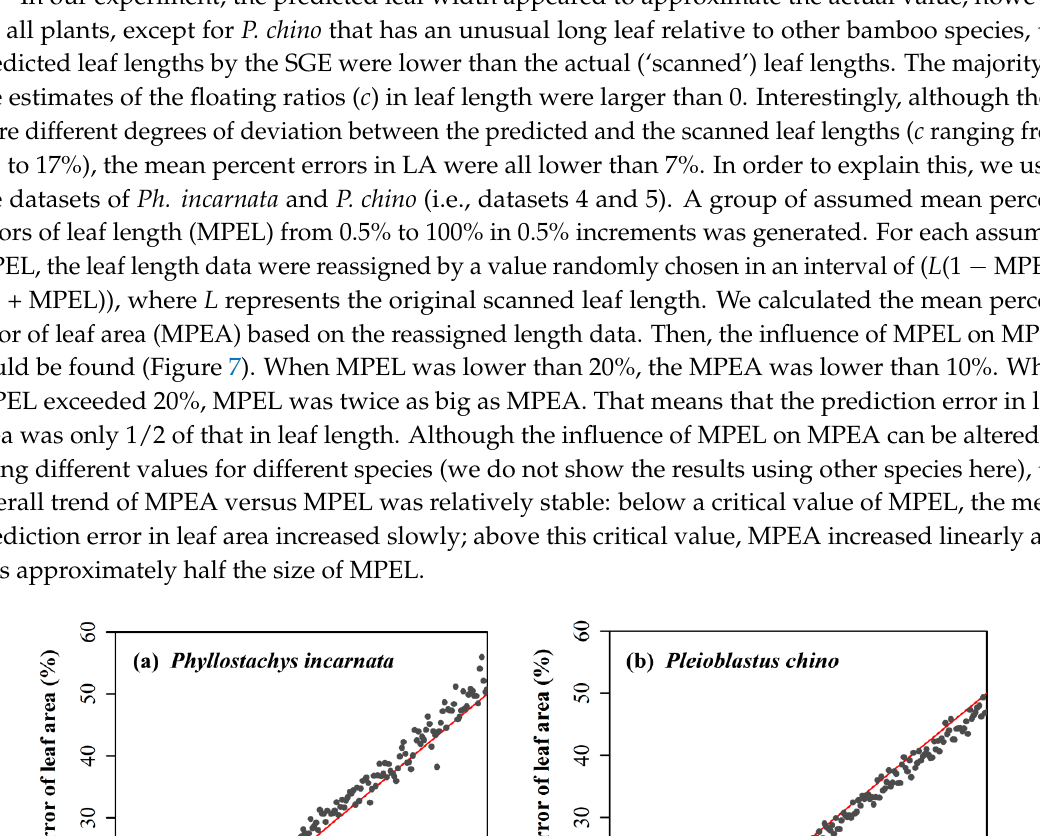
9 of 15 Figure 6. Comparison between the scanned leaf area and the predicted leaf area based on leaf length and leaf width with an additional parameter, i.e., the floating ratio in leaf length ( c ). Panels ( a – i ) represent the results of the comparison between the scanned and predicted leaf areas for the nine datasets (see 2.1 Materials for details), respectively. MPE denotes the mean percent error of leaf area. The solid line represents y = x , and the dashed line represents the regression line between the scanned and the predicted leaf areas. In each panel, the small open circles regardless of colors represent the planar coordinates consisting of the scanned leaf area (as the x -coordinate) and the predicted leaf area (as the y -coordinate). In panels ( a , b , h , i ), each color represents a species. However, the same colors in